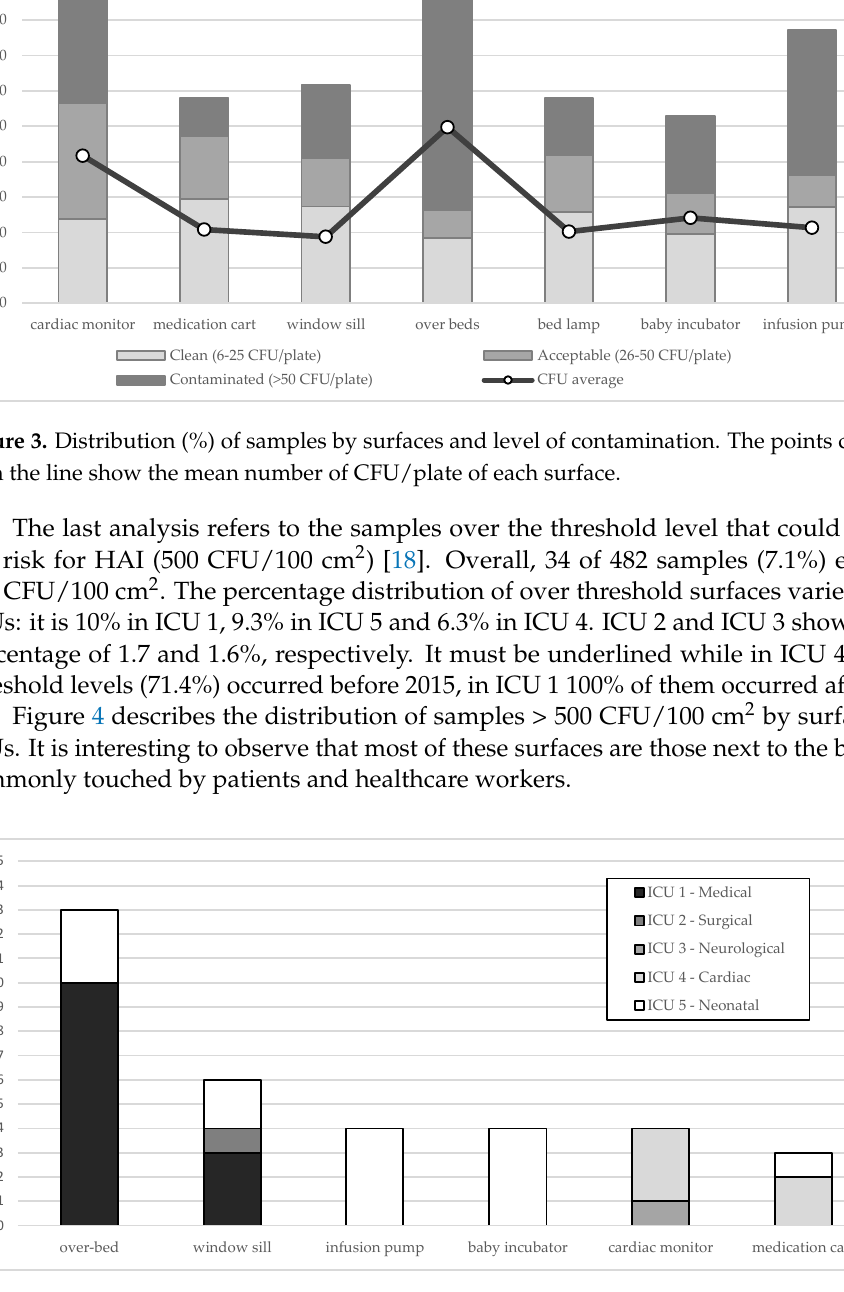
Table 6. Mean values of temperature, relative humidity, and air velocity and % of compliant samples by parameter and ICUs.